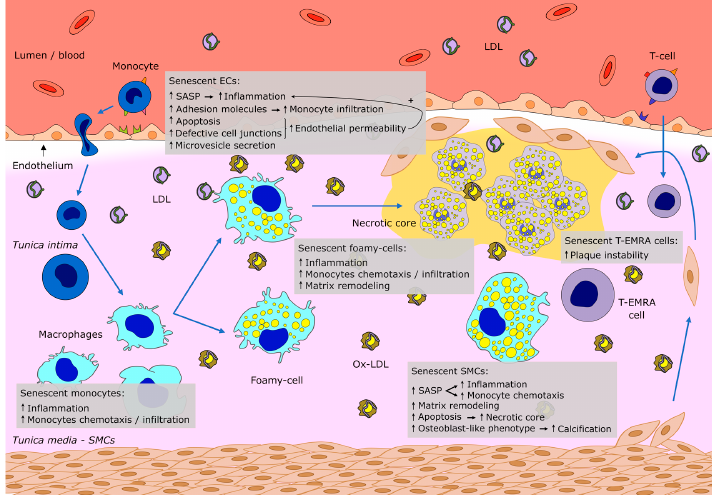
Figure 1. Schematic representation of an artery wall section showing the main events driven by senescent vascular cells, which contribute to the atheroma progression and consequently vascular disease development. The typical senescence-associated pro-inflammatory phenotype (SASP) fuels inflammation, monocyte chemotaxis and endothelial infiltration, eased by increased endothelial permeability. The accumulation of oxidized lipids in the vascular wall and consequent foam cell formation occur along with the recruitment of vascular SMCs from the media to form a fibrous cap, which progressively becomes destabilized. Senescent immune cells found at lesion sites contribute to plaque instability, acting synergistically with calcification events to increase the vessel vulnerability. ECs—endothelial cells, SMCs—smooth muscle cells, LDL—low density lipoprotein, SASP—senescent-associated secretory